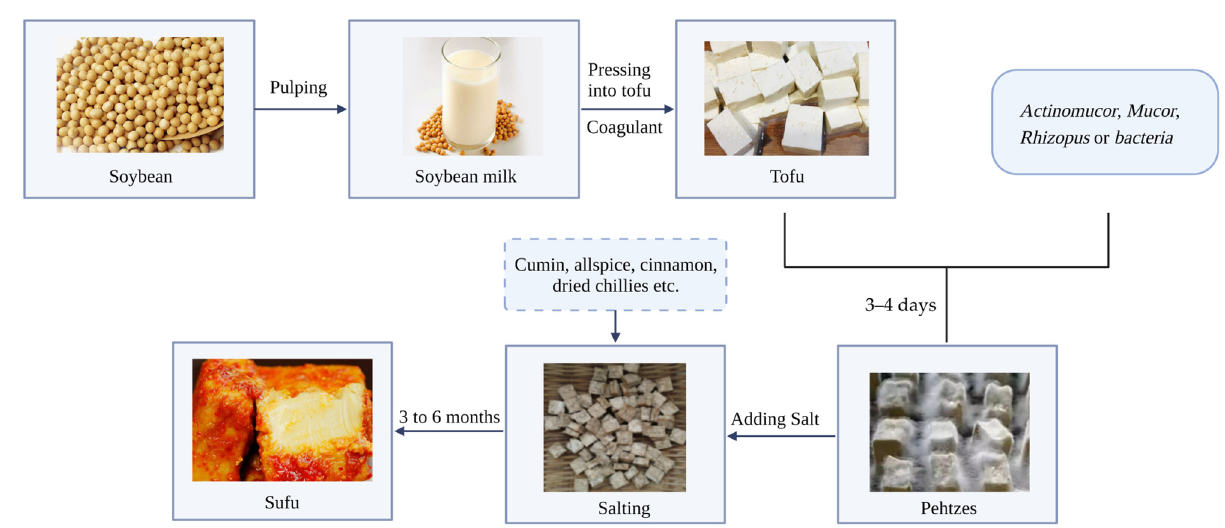
Figure 1. A diagram of sufu fermentation.